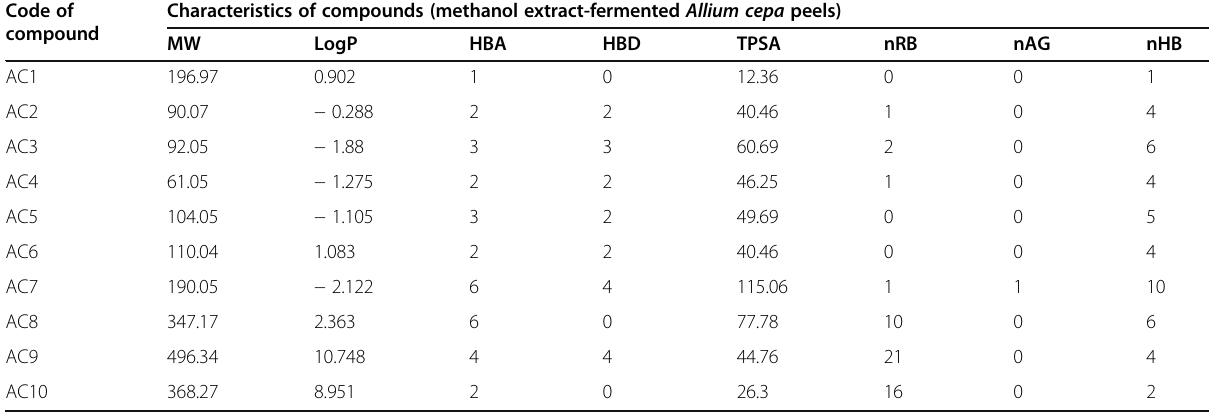
Table 4 Characteristics of compounds identified from GCMS analysis of fermented Allium cepa peel methanolic extracts Code of compound